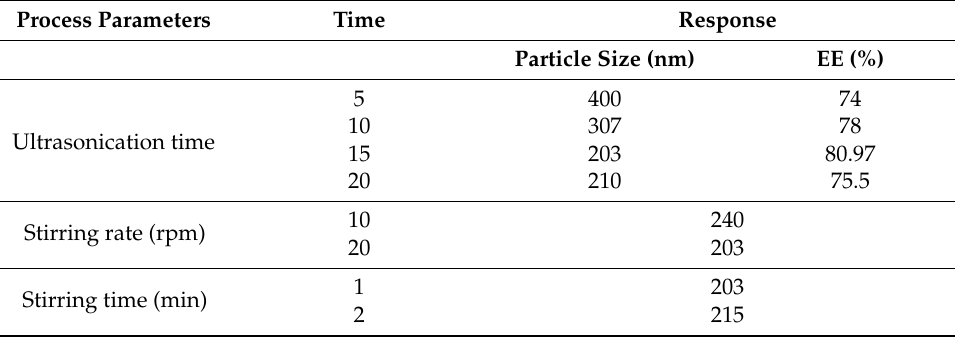
Table 2. Optimization of formulation based on process